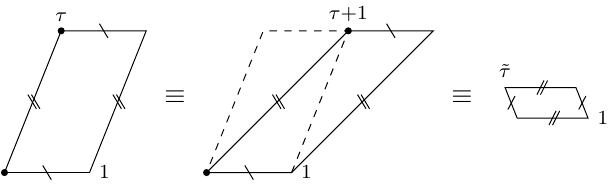
Figure 2. The torus with parameter τ is equivalent to the tori with parameters τ +1 and ˜ τ =